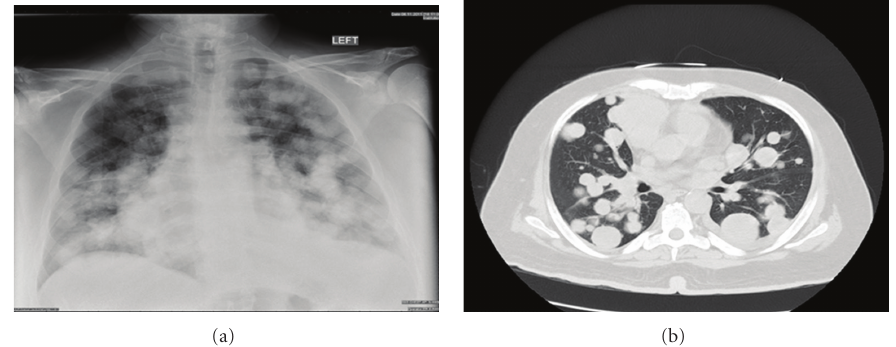
Figure 7: (a) Chest radiography showing multiple bilateral pulmonary nodules suggesting metastasis. (b) CT-scan of the chest revealing numerous pulmonary nodules suspicions for